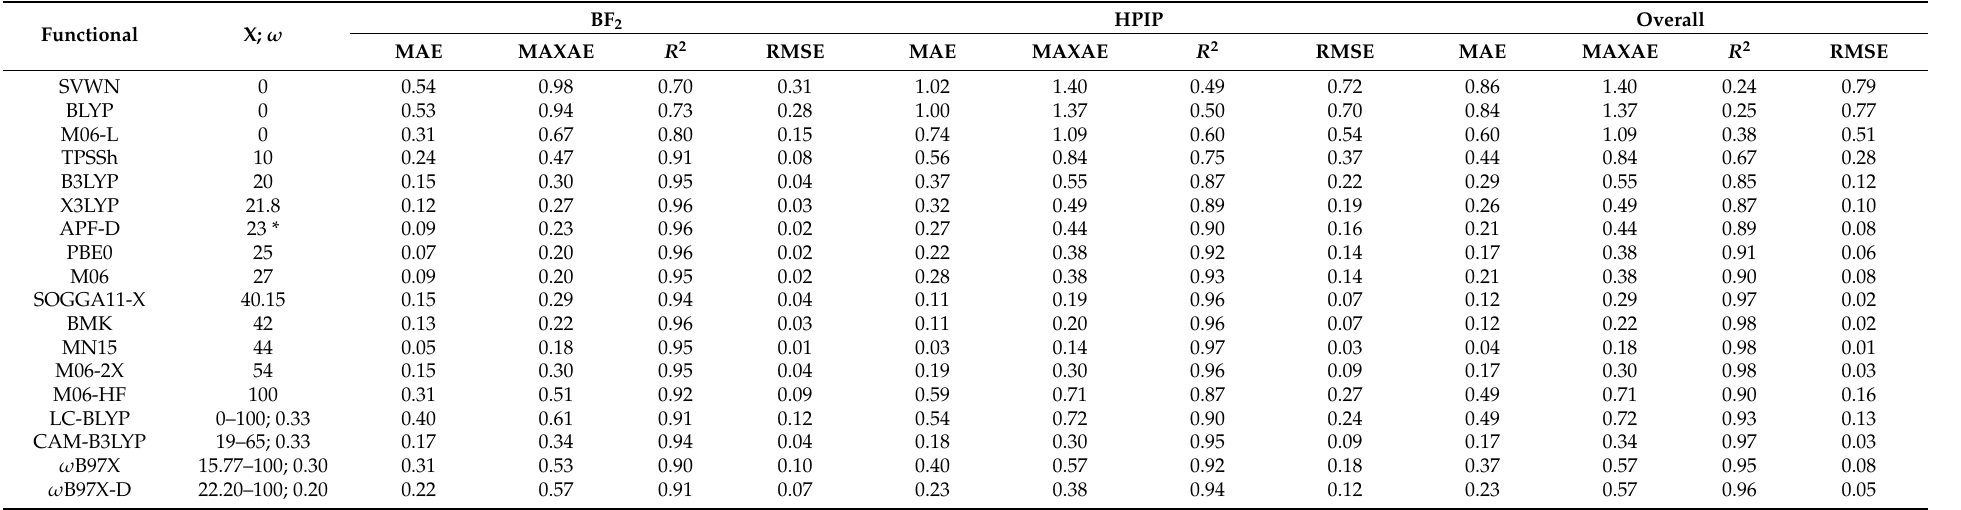
Table 1. DFA errors (in [eV]) established for the vertical energy, determined with respect to CC2